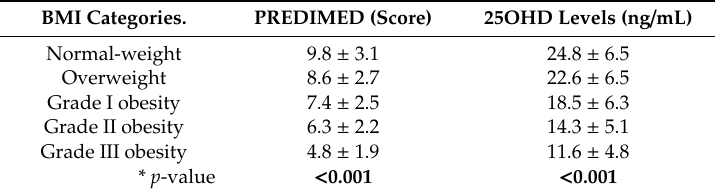
Table 2. The PREDIMED score and 25OHD levels in the population study across BMI categories.